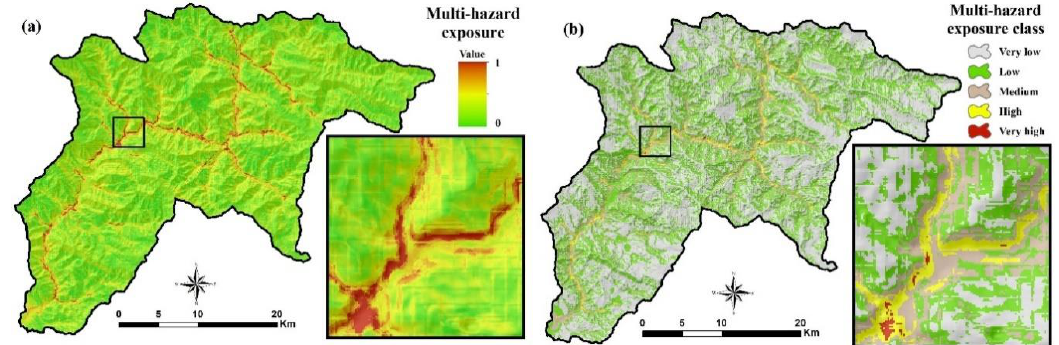
Figure 10. ( a ) Multi-hazard exposure map, and ( b ) multi-hazard exposure class map.